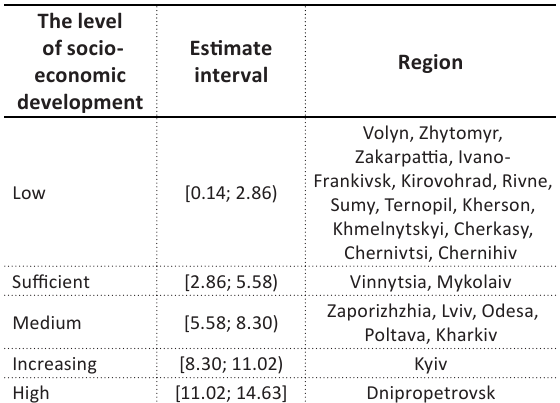
Table 1. Region grouping by the level of socio- economic development for 2016–2018